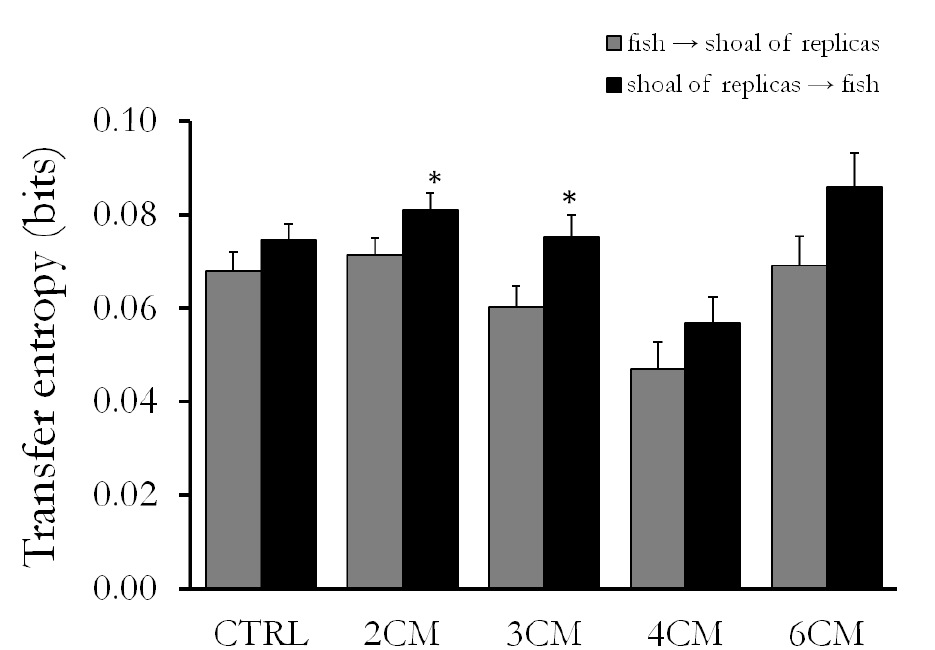
Figure 11 . Transfer entropy for experiments on the interaction between live fish and a shoal of replicas of different body length maneuvered by a robotic arm along pre-programmed trajectories. Experiments refer to six conditions, including a control condition (CTRL) in which the lateral compartments were empty, and four experimental conditions with replicas of size: 2, 3, 4, and 6 cm. Error bars represent ± standard errors and a star indicates a significant difference between the two directions of information flow. [Reproduced from (Bartolini et al.,